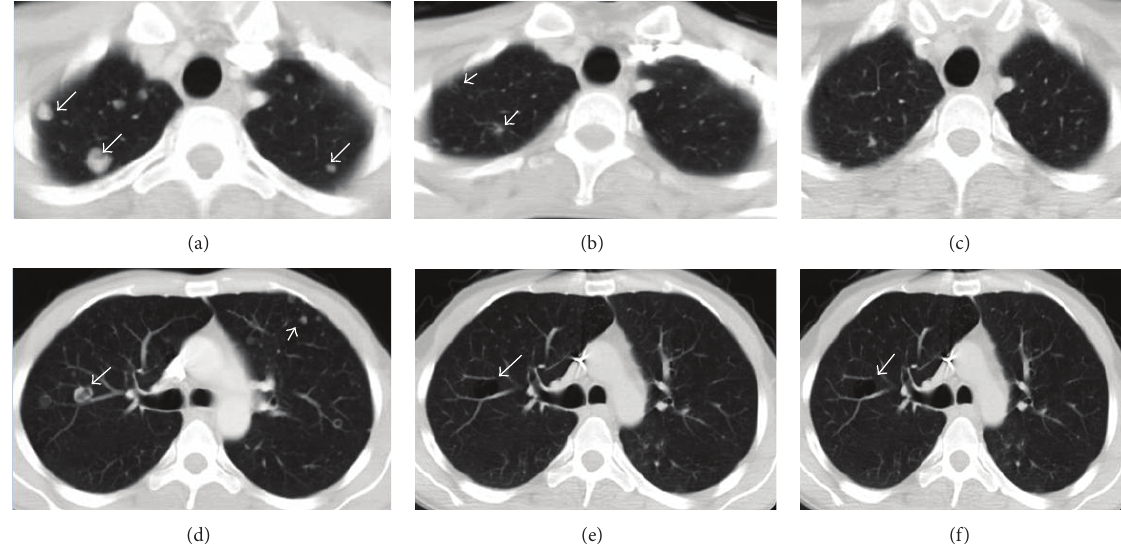
Figure 1: In different sections (above and bottom) regressing of metastatic nodules in the lungs ((a) and (d), at onset; (b) and (e), October; (c) and (f), December); note the cavitations in (e) and (f).